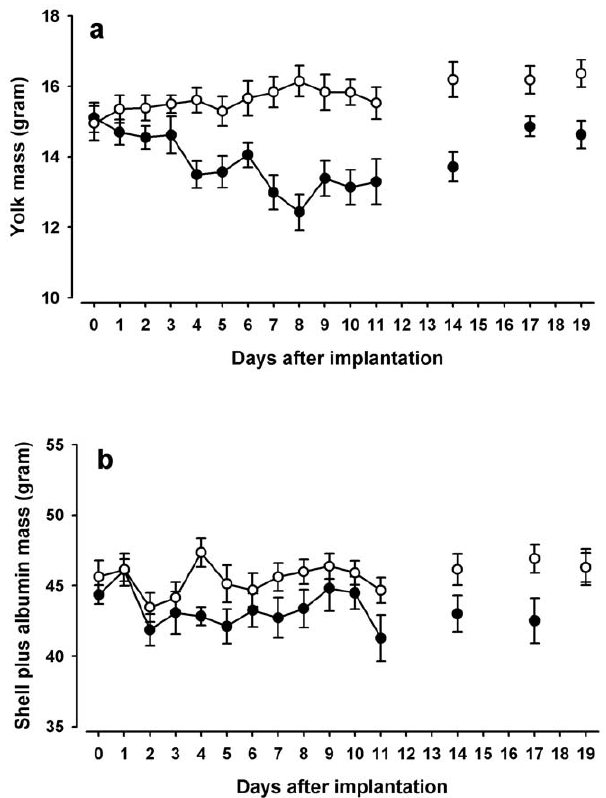
Figure 5. Egg mass after pellet implantation. Mean ( 6 SE) yolk N mass (a) and shell plus albumin mass (b) in eggs from hens implanted ) or placebo ( # ) pellets. Eggs from days 12, 13, with corticosterone ( 15, 16 and 18 were incubated to hatch